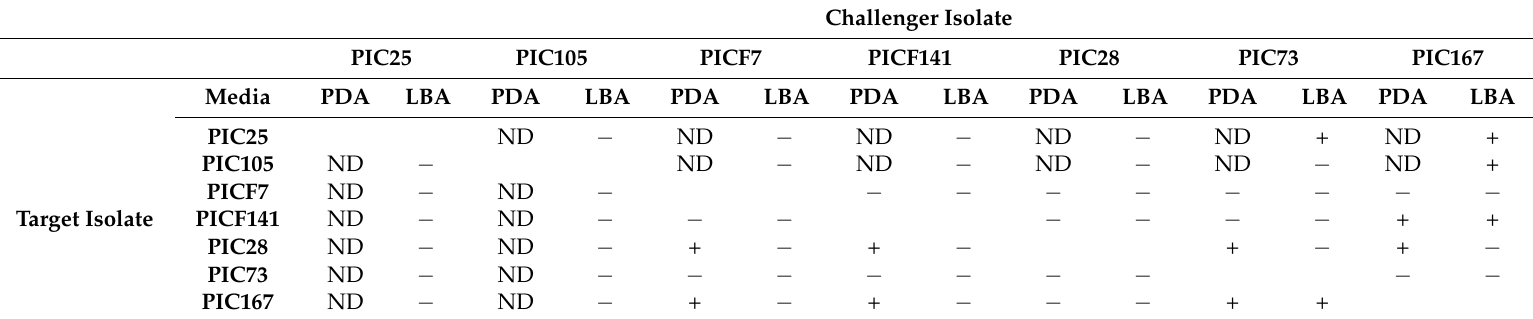
Table 6. In vitro dual tests among olive rhizobacteria showing biocontrol activity against Verticillium wilt of